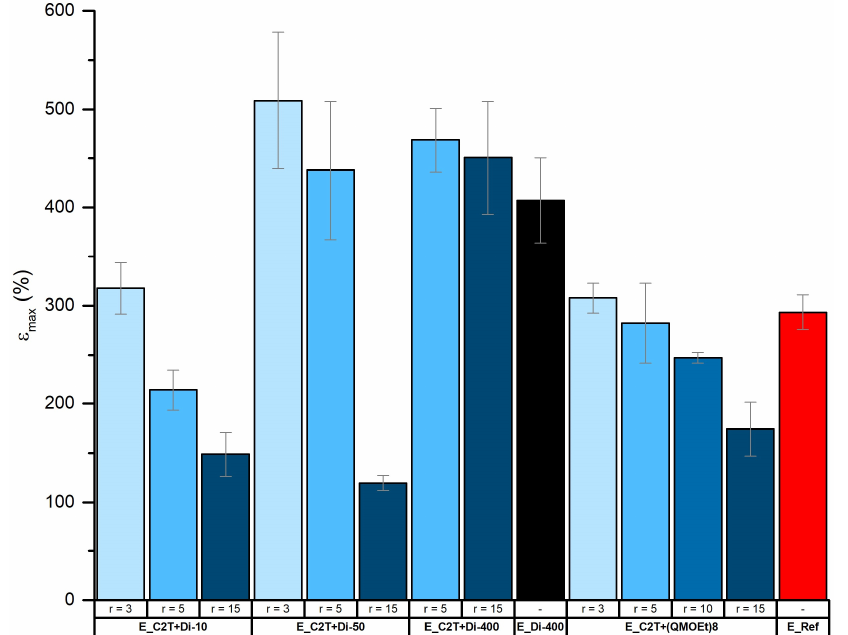
Figure 9. Elongation at break (%) of commercial coating E_Ref and elastomers prepared via the reaction between C2T and Di-10, Di-50, Di-200, and (QM OEt ) 8 , respectively. Film thickness was ~100 µ